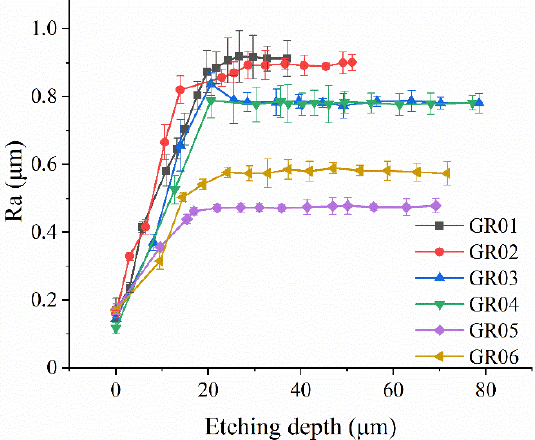
Figure 2. The variation of the surface roughness of six resonators with chemical etching depth.